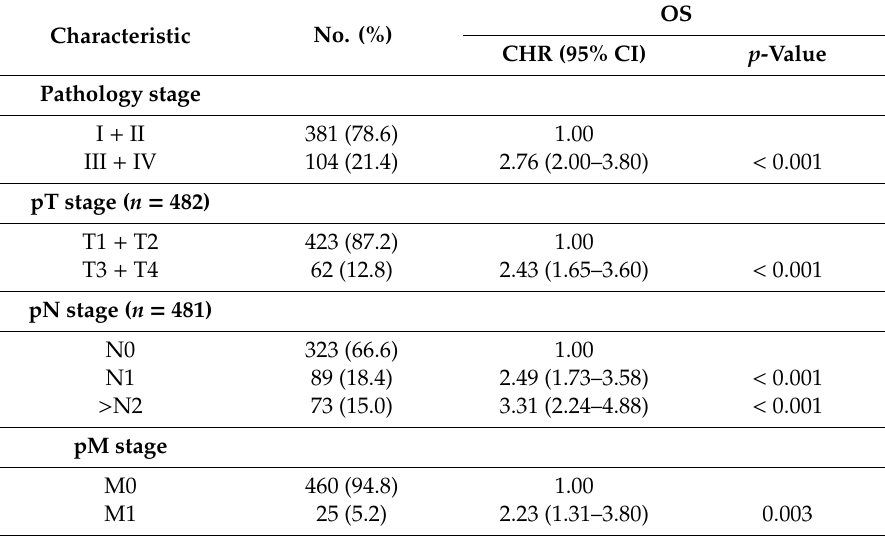
Table 1. Univariate Cox’s regression analysis of clinicopathological characteristics for overall survival of 485 patients with lung adenocarcinoma (LUAD).